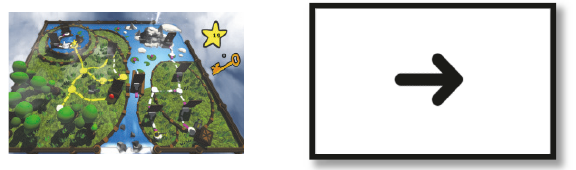
Figure 1: Screen shot of game and nongame versions of SIAK. Left panel shows example game ‘world’ that the learners explore. Right panel shows a nongame simple interface.